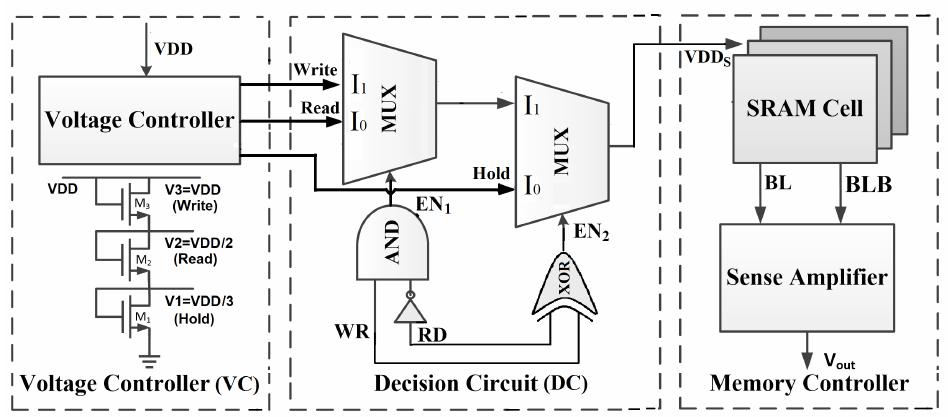
Figure 4. Reconfigurable VDD (R-VDD) scaled block diagram for supply voltage optimization of SRAM cell for various modes of operations.